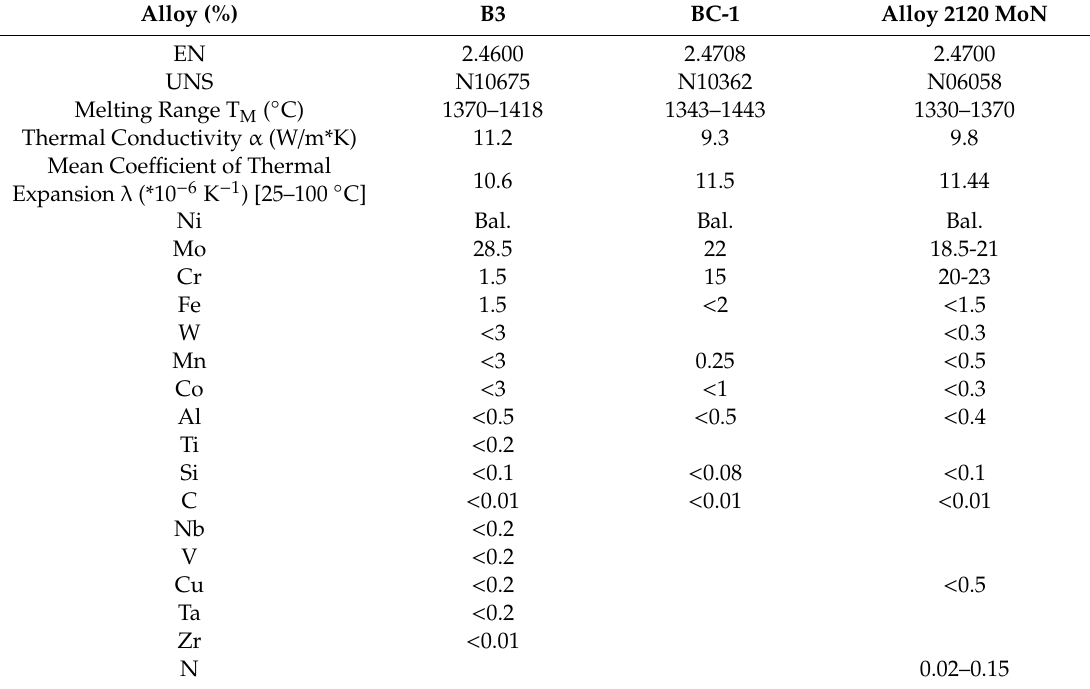
Table 2. Physical properties and chemical composition of Hastelloy B3, Hastelloy BC-1, and Alloy 2120 MoN